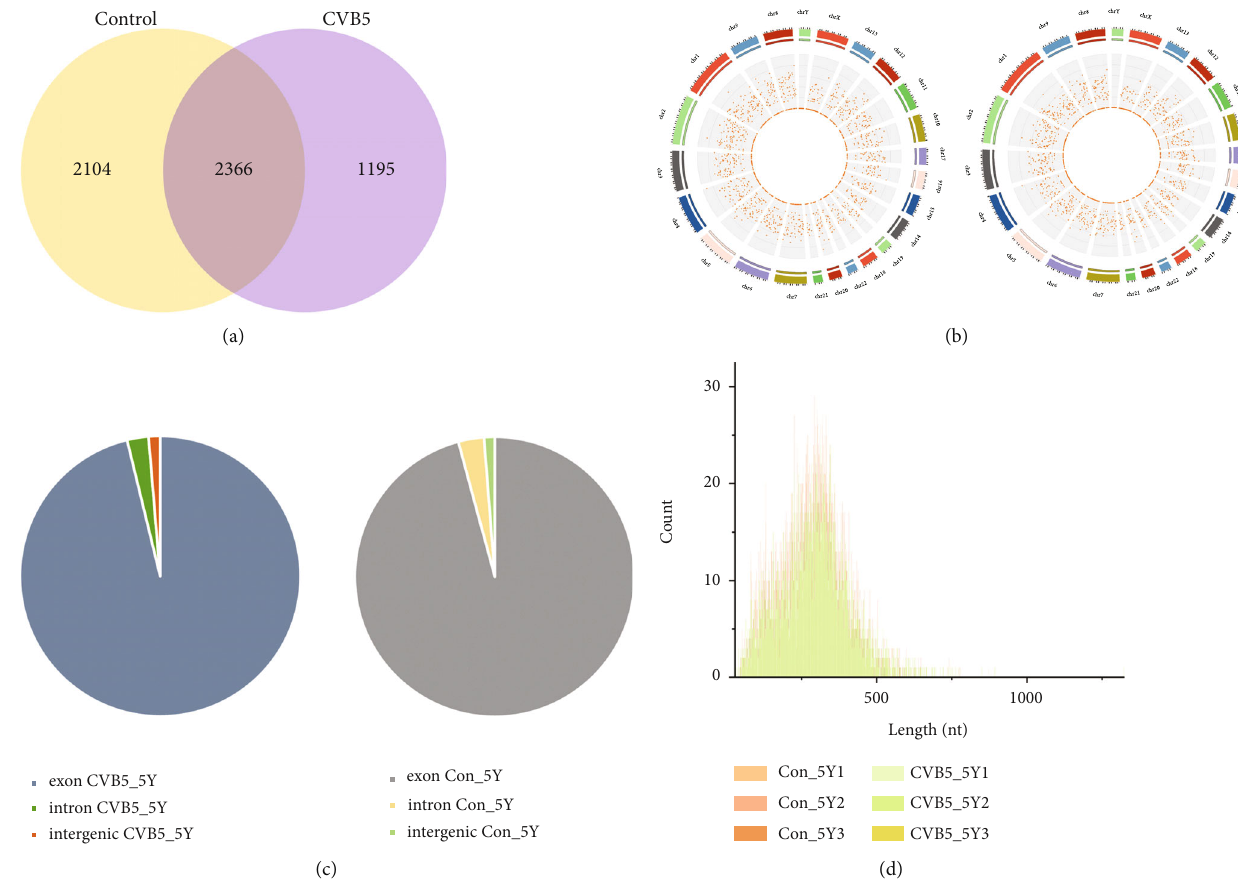
Figure 1: Genomic features of circRNAs detected in CVB5-infected SH-SY5Y cells. (a) Venn diagram of the number of di ff erentially expressed circRNAs in each group. A total of 2,366 circRNAs were expressed in two groups. (b) Genomic distribution of circRNAs. (c) Chromosomal distribution of circRNAs. (d) Length distribution statistics of